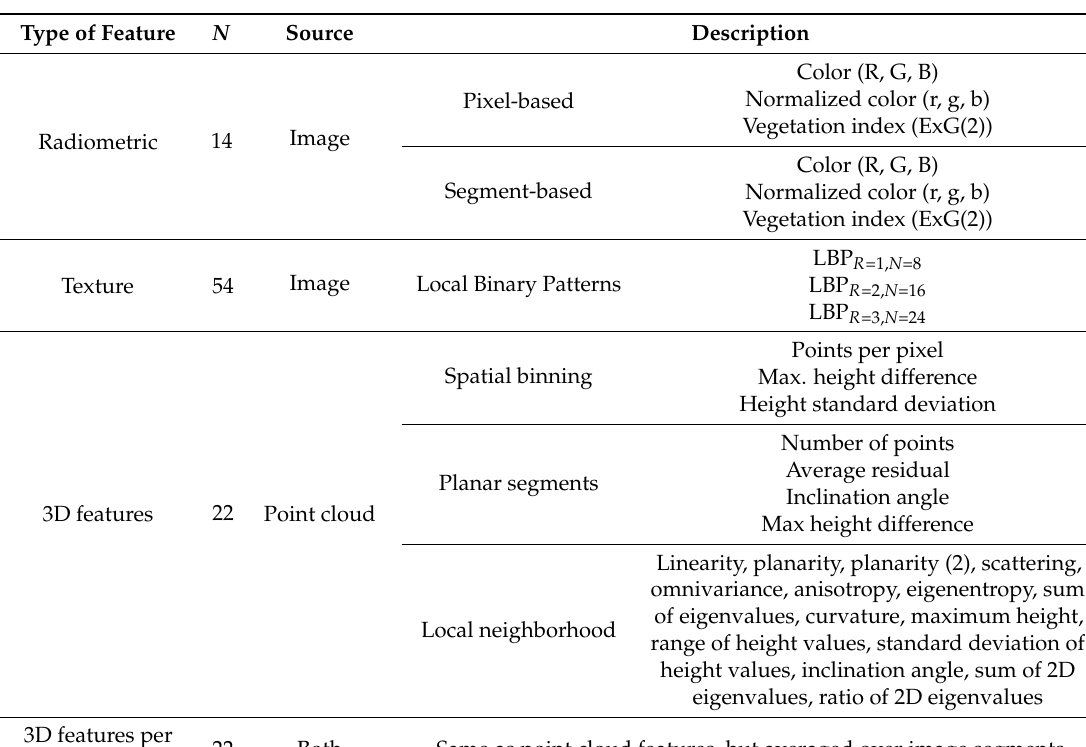
Table 1. A list of the features extracted from the point cloud and orthomosaic in the current study. N refers to the number of features in the